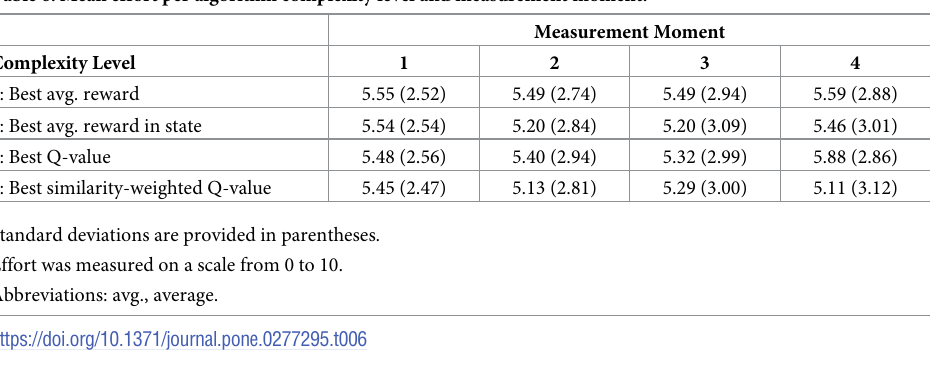
Table 6. Mean effort per algorithm complexity level and measurement moment.